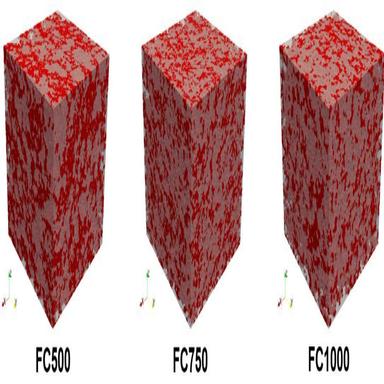
Pore structures of the FC specimens (Note: the red in each figure shows the pores within the matrix.) (For interpretation of the references to colour in this figure legend, the reader is referred to the web version of this article.)